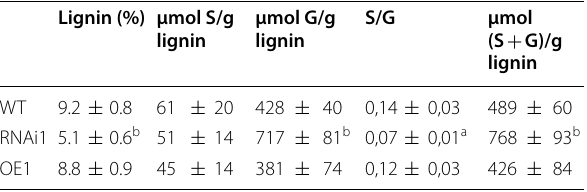
Lignin content and monomer composition were measured by derivatization followed by reductive cleavage (DFRC). Lignin contents are presented as percentage of cell wall dry weight. Data presented as mean from four independent biological replicates. Letters indicate significant differences between transgenic line and WT control G, S Guaiacyl and syringyl monomers, respectively a p < 0.05 b p < 0.01, Student’s t test